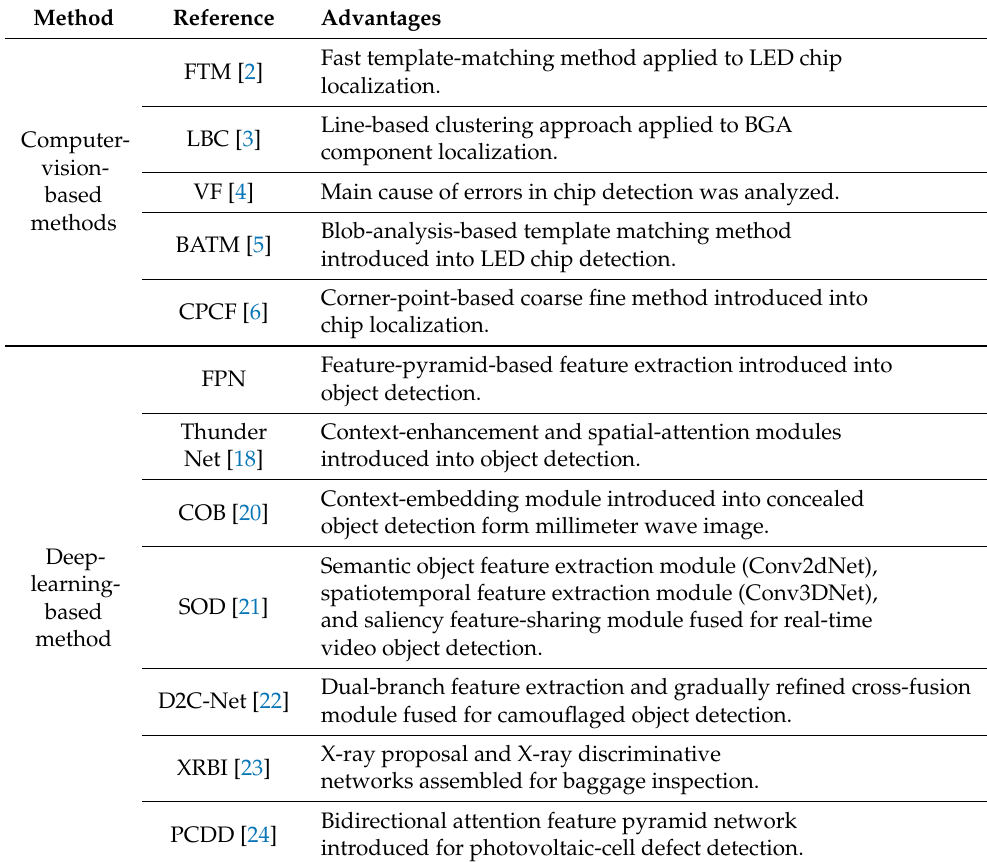
Table 1. Advantages of existing